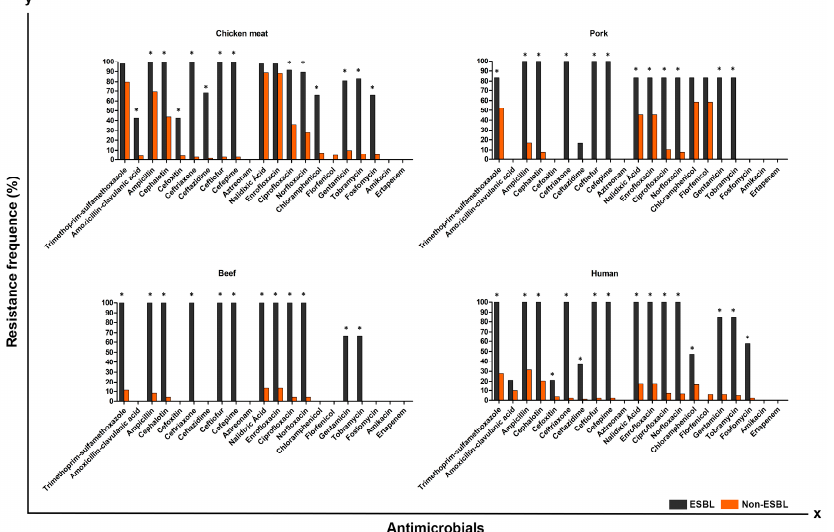
Figure 2. Antimicrobial resistance exhibited by ESBL-producing and non-ESBL-producing P. mirabilis strains isolated from chicken, pork, beef, and UTI-CA. * p < 0.05 by Fisher test.